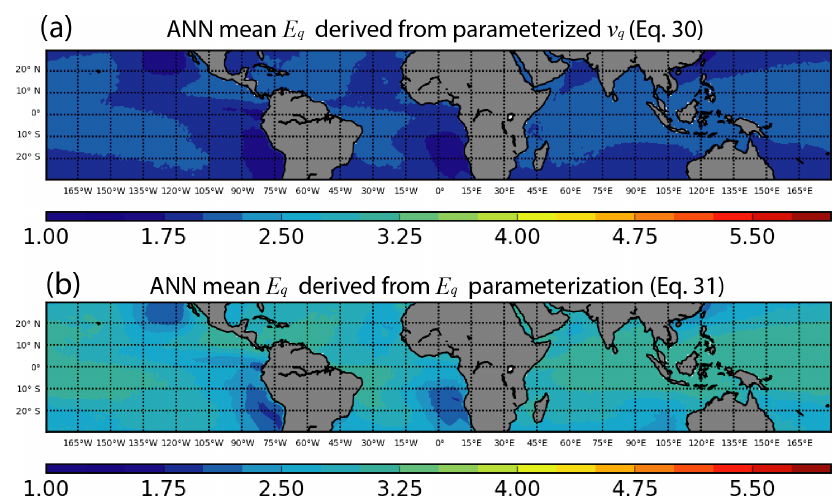
− 0 . 49 f 3 liq liq + 10 . 69 f 3 parameterization scheme in Eq. liq liq